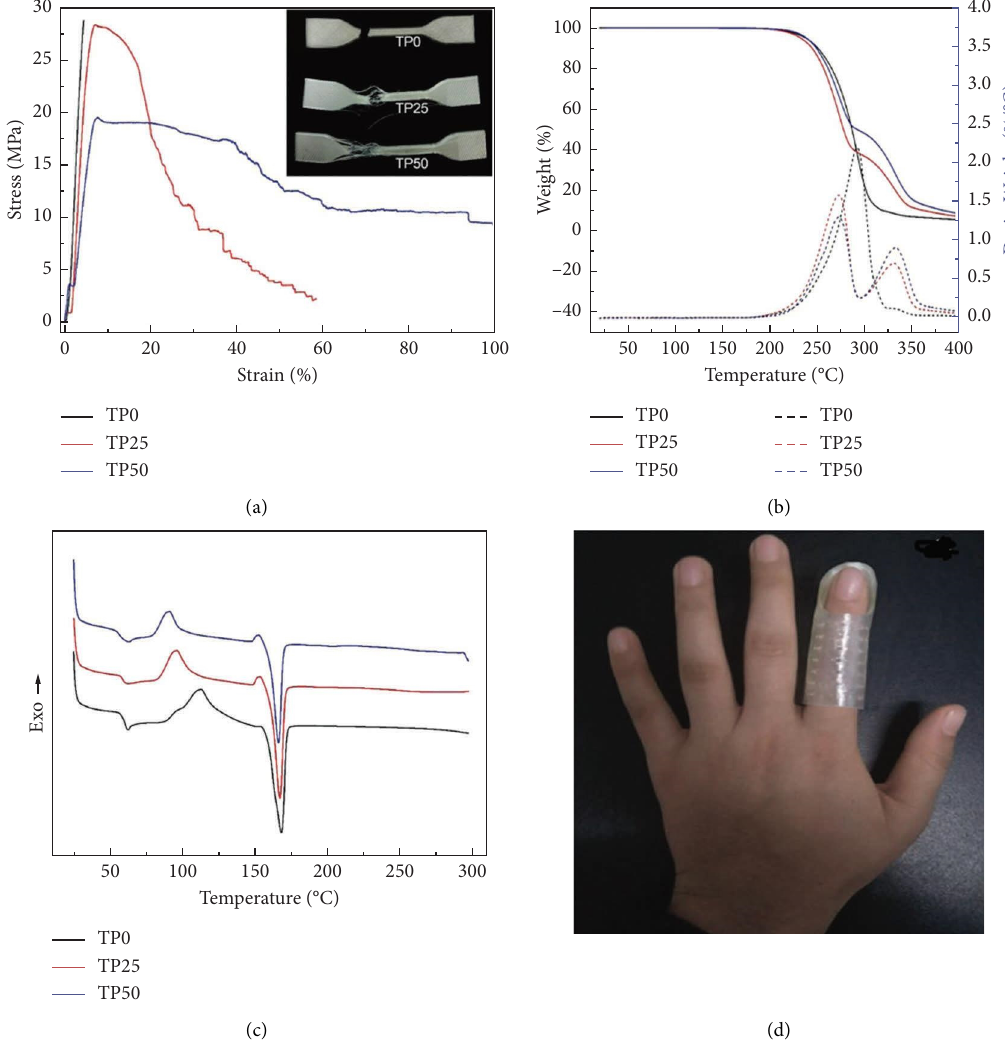
Figure 15: (a) Tensile stress-strain curves. (b) TGA and DTG curves. (c) DSC curves. (d) Finger